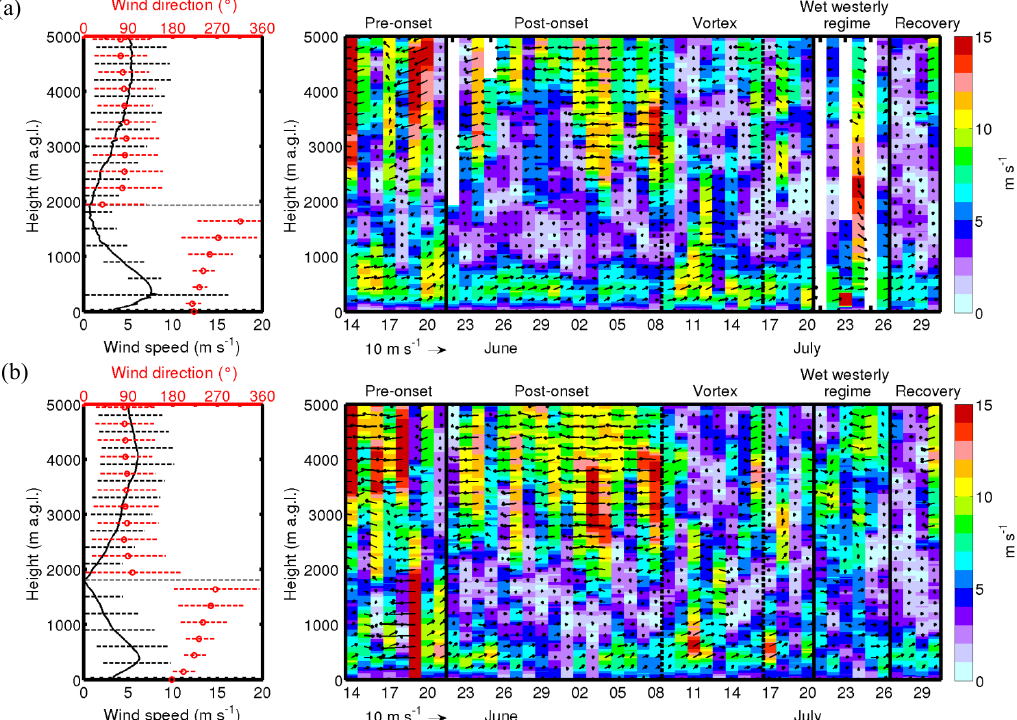
Figure 2. Mean profiles of wind speed (black solid line) and direction (red dots) including their standard deviations based on 06:00UTC soundings at Kumasi (a) and Savè (b) on the left. The horizontal grey dashed line indicates the monsoon height. Times series of the horizontal wind vector (arrows) and absolute value of the wind speed (colour coded) at 06:00UTC at Kumasi (a) and Savè (b) on the right. Different phases of the monsoon are indicated according to Knippertz et al.